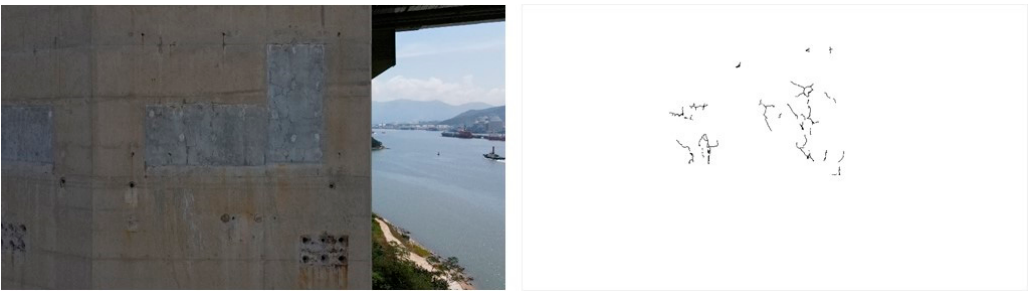
Figure 14. Images of concrete surface and corresponding labeled cracks.